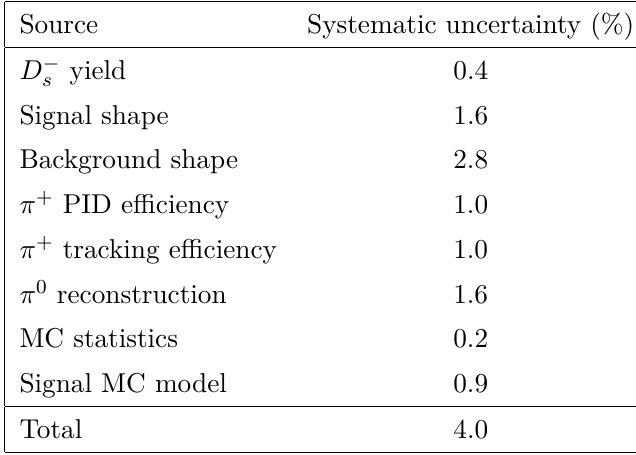
Table 8 . Systematic uncertainties relative to the central value in the BF measurement. the corresponding systematic uncertainty. The π + tracking (PID) efficiency is studied with the processes e + e − → K + K − π + π − ( e + e − → K + K − π + π − ( π 0 ) and π + π − π + π − ( π 0 ) ).